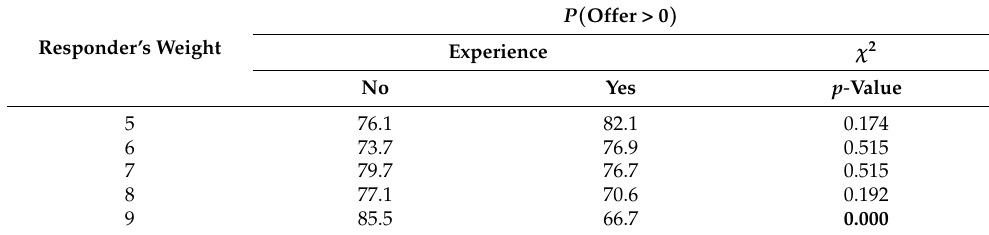
Table A3. Responders’ Probability to Receive an Offer by Nominal Voting Weight and Experience.